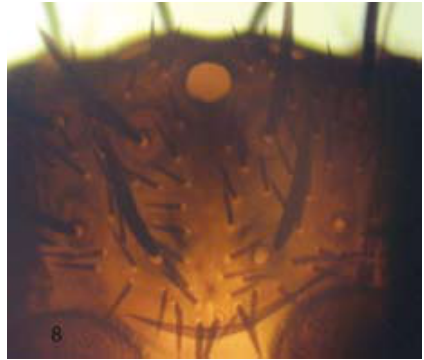
Fig. 8. Rhynchomicropteron nudiventer male, frons.